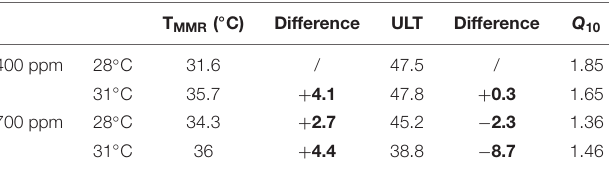
TABLE 2 | Temperature at maximum metabolic rate (T MMR ) and upper lethal temperature (ULT) as described by an Exponentially Modified Gaussian Function (EMG) model for Trochus maculatus after 12-weeks exposure to elevated temperature (31 ◦ C) and elevated CO 2 (700 ppm). T MMR ( ◦ C)